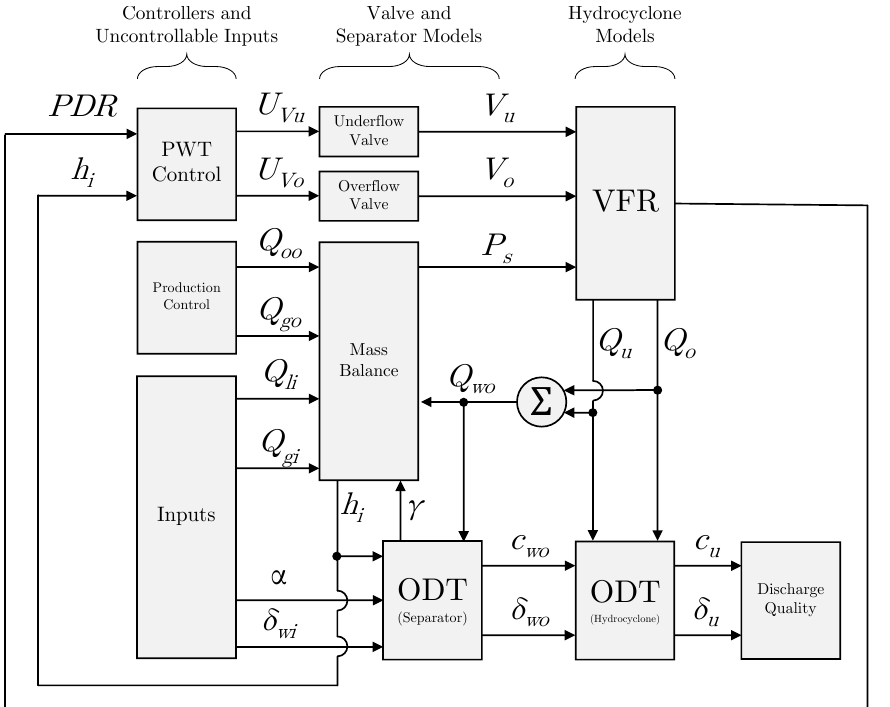
Figure 2. Overview of the combined grey-box model of the separator and hydrocyclone with a control unit that sets valve openings to the underflow and overflow valve and a production control unit that sets oil and gas flow